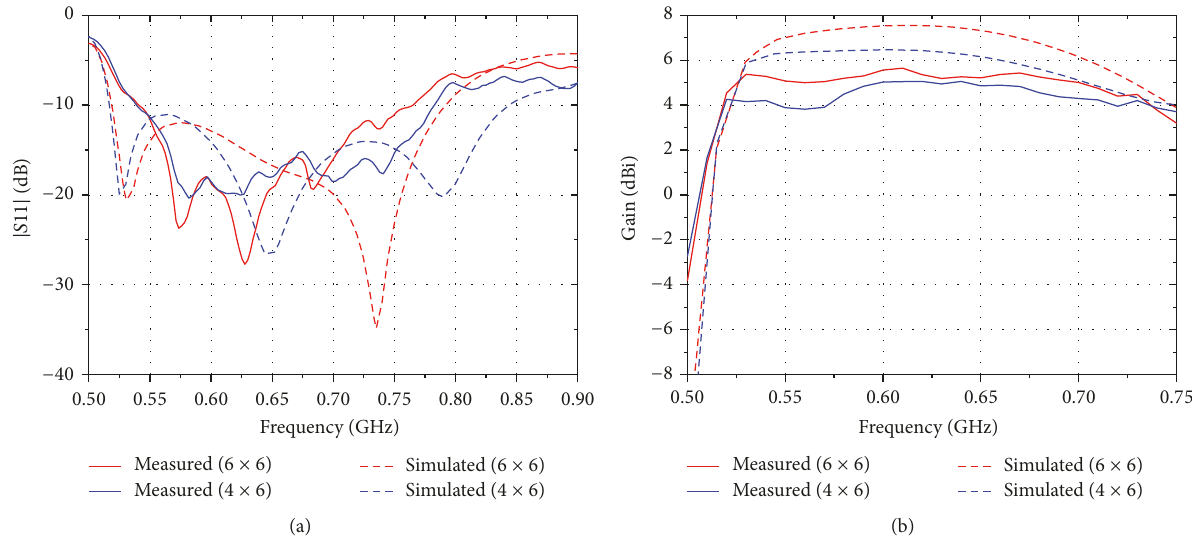
Figure 10: The simulated and measured results of the antenna in Figure 9(a): (a) return loss and (b) antenna gain.